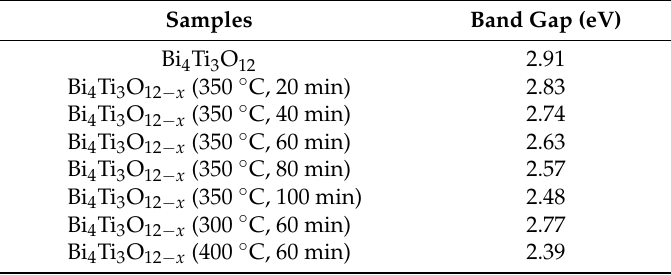
Table 1. Band gaps of the pristine Bi 4 Ti 3 O 12 and various Bi 4 Ti 3 O 12 − x